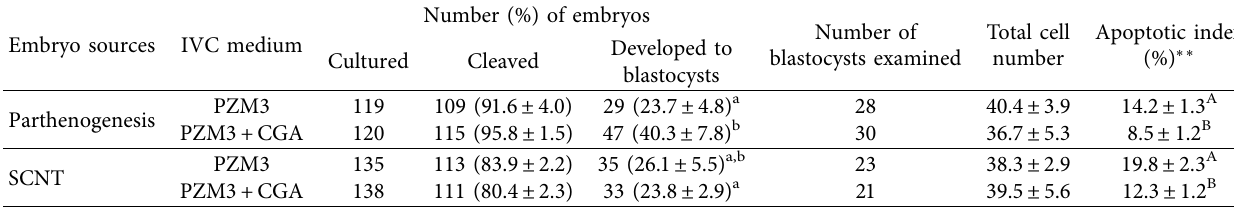
∗ All experiments were repeated seven times. Percentage data are expressed as mean ± SEM. Table 2: Efects of CGA supplementation during in vitro culture (IVC) on the development and quality of Ban pig somatic cell nuclear transfer (SCNT) embryos ∗